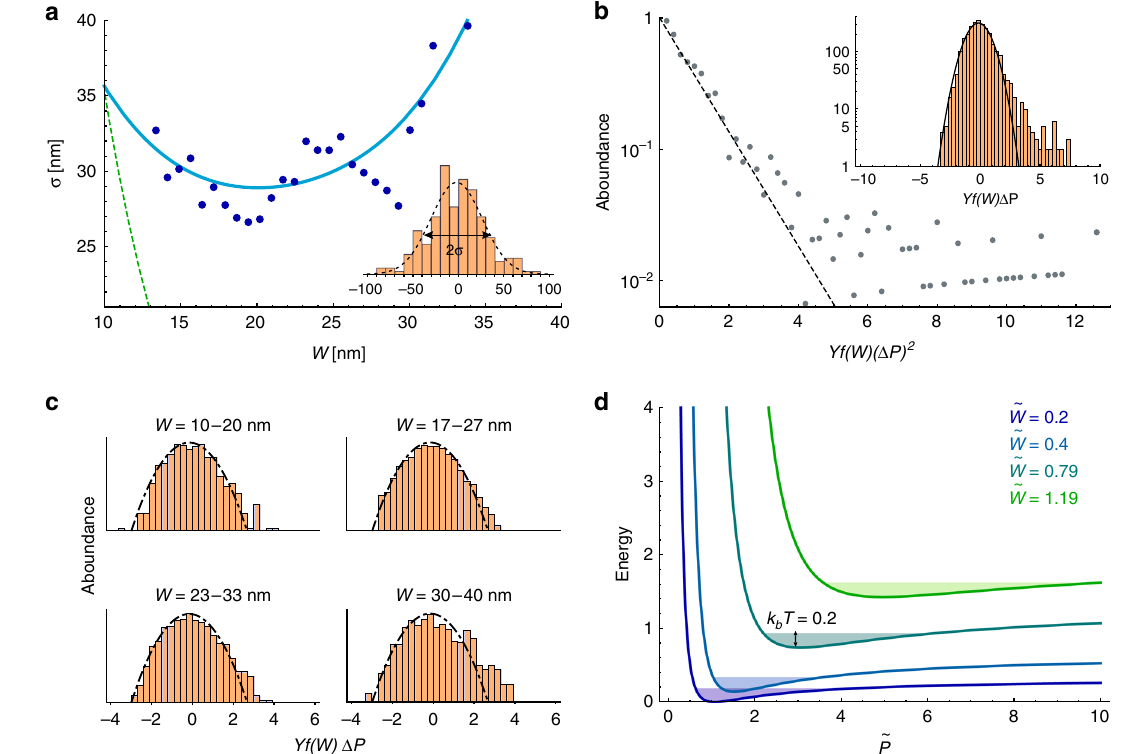
Fig. 4 Statistics of ribbon shapes. a The standard deviation of the pitch of twisted ribbons as a function of ribbon width. The cyan line is the theoretical prediction, with Y = 9.5 MPa . The green dashed line is the calculated std for a compatible twisted ribbon with the same dimensions. Inset: measured pitch distribution around the average pitch and the determination of σ , obtained for W ¼ 21 (cid:10) 1 nm . b The abundance of ribbon con fi guration vs. Yf ( W )( Δ P) 2 , (with Yf ( W ) as in a and T = 300 K ). An exponential dependence (dashed line) is found up to three standard deviations. Larger deviations are found to have higher probability than Gaussian. Data (~2800 data points) were collected from the entire range of widths (10 − 40 nm) of twisted ribbons. Inset: the distribution of normalized pitch deviations Δ P (semi log plot) with a Gaussian fi t (solid line). The distribution is positively skewed. c Distributions of Δ P at different ranges of ribbon widths (indicated in each panel). The skewness varies non-monotonically with W (with increasing width: skewness values are: 0.38, 0.22, 0.39, and 0.42). d The (dimensionless) energy versus pitch as calculated from Eq. (5) for twisted ribbon with t = P 0 = 1 for different values of ~ W (indicated). The solid areas illustrate accessible states at a fi xed (dimensionless) thermal energy, f k B T ¼ 0 :